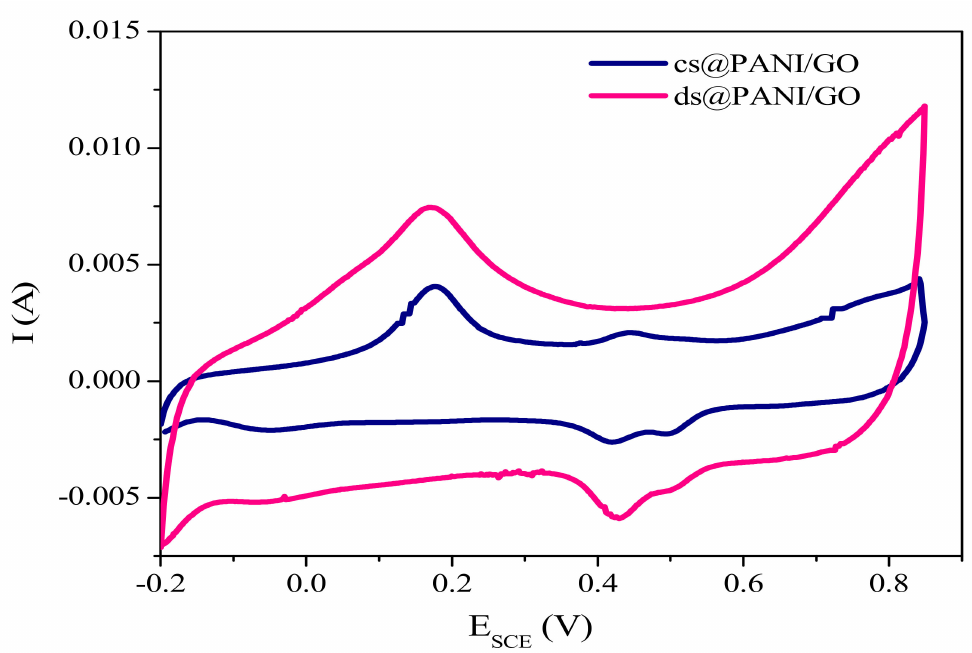
Figure 7. Cyclic voltammogram of ds@PANI / GO and cs@PANI /